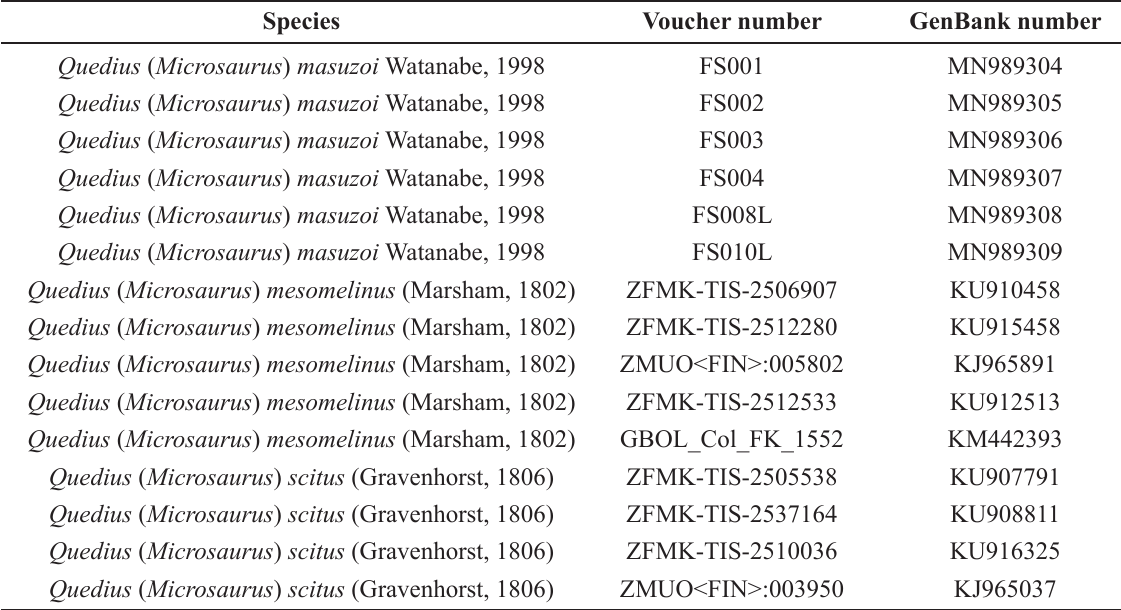
Table 1. List of analyzed specimens with DNA barcodes and their GenBank accession numbers.